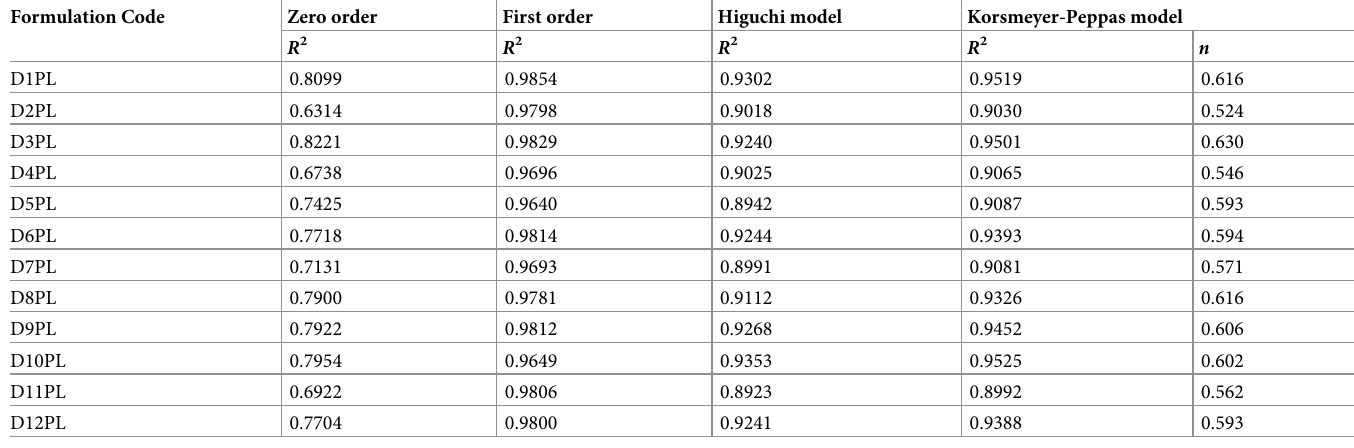
Table 3. Kinetic modeling of drug release profile of PL formulations. Formulation